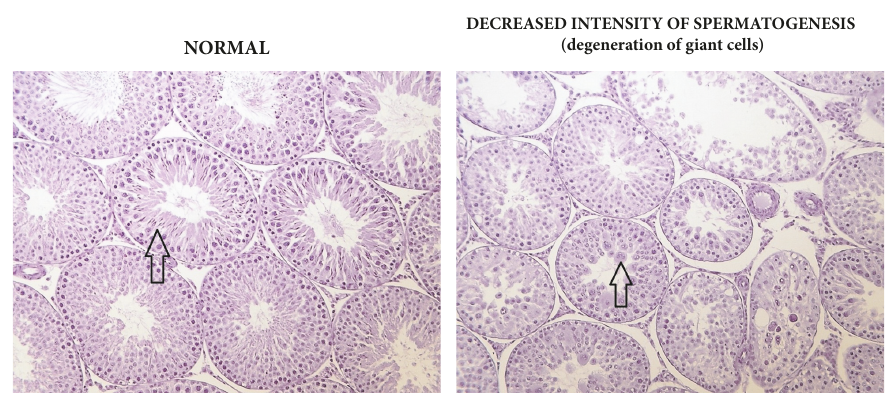
Figure 4: Testes: comparison of normal (control) tissue to tissue in a male from the 3000/4000 mg/kg bw/day group showing decreased intensity of spermatogenesis, 14-day